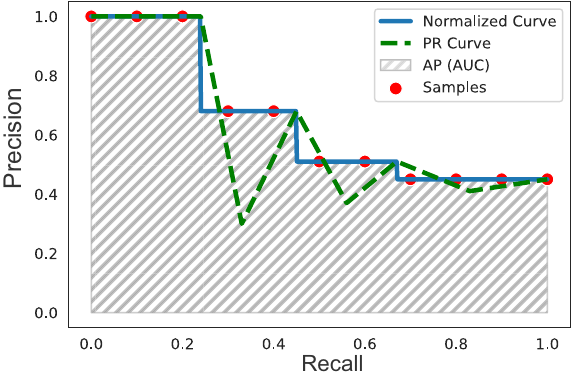
Fig. 12 PR curve. Exemplary precision values corresponding to given recall values, shown by red dots. According to VOC2010, to avoid the wiggly representation of PR curve, shown by dashed green lines, precision values take the previous maximum values to the left to generate the normalized curve, shown by solid blue lines. The fi nal AP is calculated as the area under the normalized